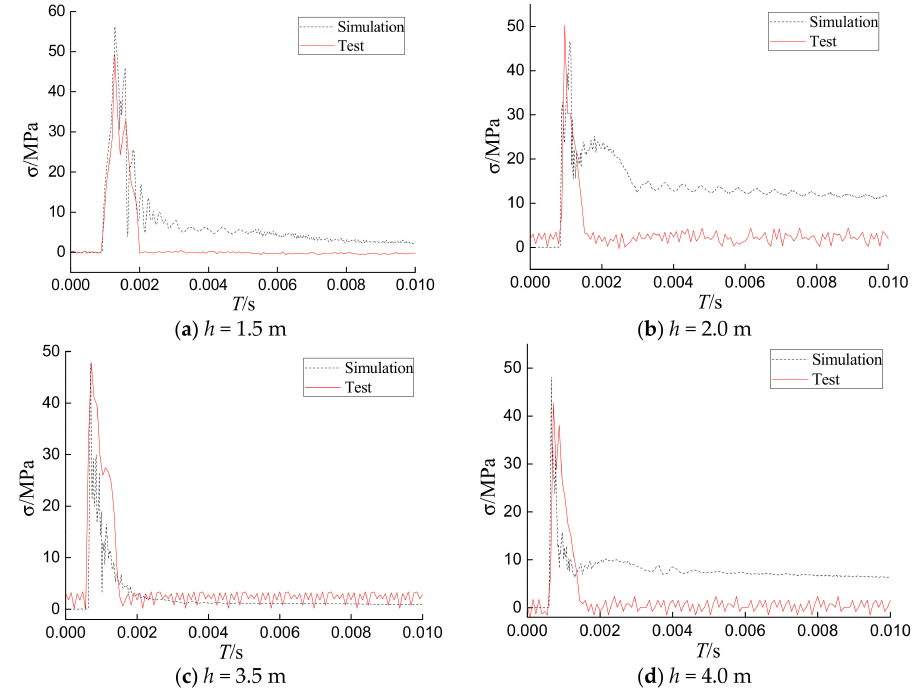
Figure 14. Comparisons of numerical and test results of the internal stress values under different impact